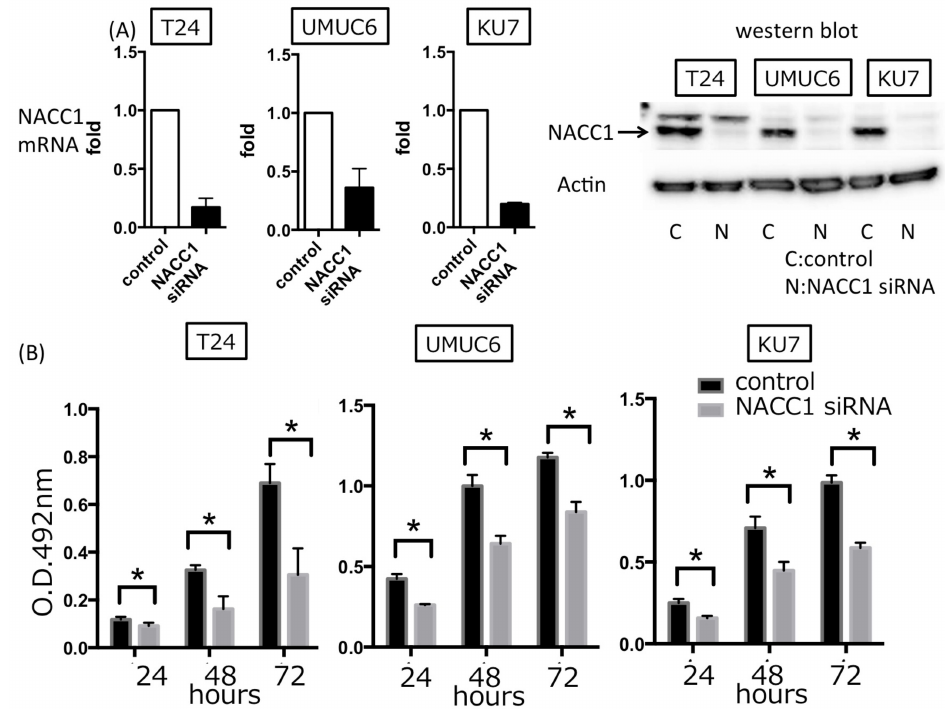
Figure 2. ( A ) The effect of transient NACC1 siRNA transfection in three UC cells. The left graph is qRT-PCR for NACC1 mRNA. The right image is western blot for NACC1 protein; ( B ) Methane thiosulfonate (MTS) assay in T24, UMUC6, and KU7 cells. Cell proliferation was suppressed by transient transfection of NACC1 siRNA (* p < 0.05).